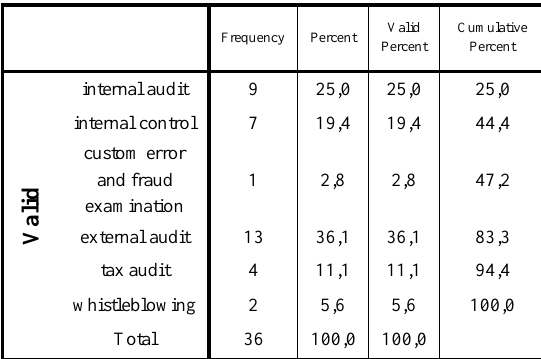
Table 13: Most Important and Effective Tools to Prevent Errors and Fraud